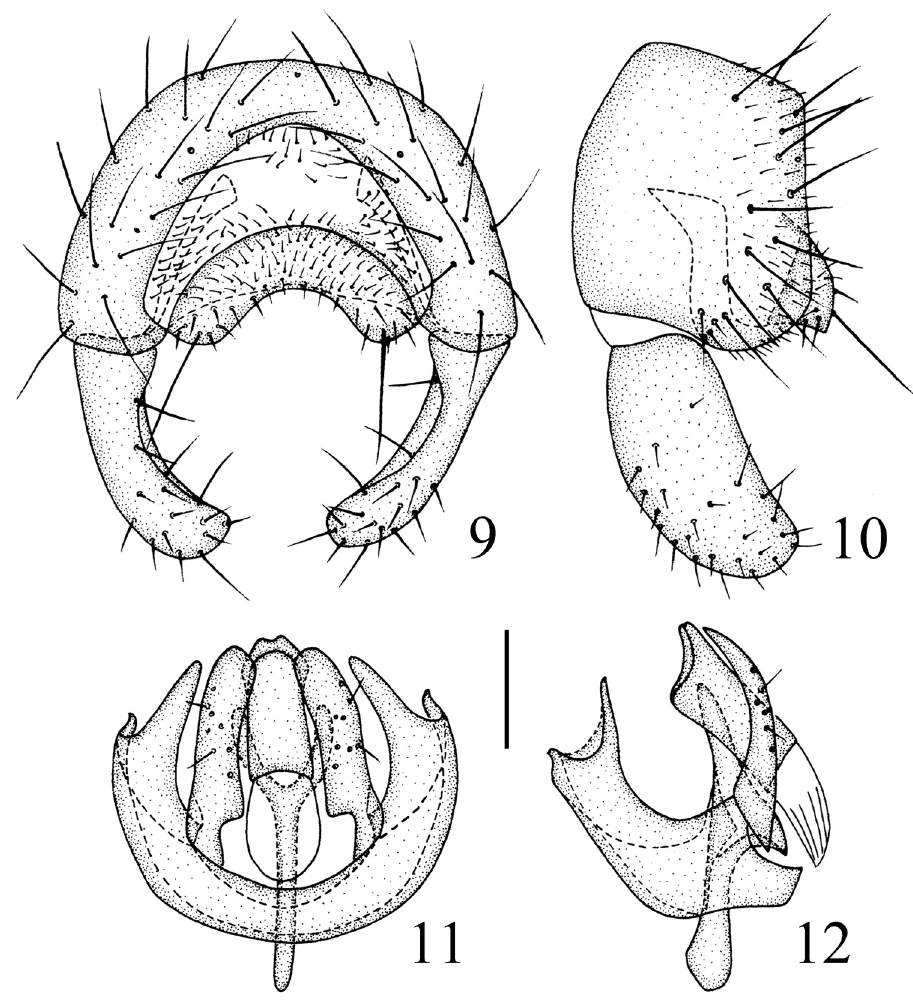
Figures 9–12. Siphunculina scalpriformis sp. n., holotype. 9 epandrium, posterior view 10 epandrium, lateral view 11 hypandrium and phallic complex, ventral view 12 hypandrium and phallic complex, lateral view. Scale bar: 0.1 basal segment brownish, with short pubescence. Proboscis black to yellowish brown with yellow setulae; palpus yellow with yellow setulae. Thorax black with gray microtomentum, evenly covered with short setulae. Scutum as long as wide. Thoracic pleuron shiny black without microtomentum. Scutellum 0.6 times as long as wide; 3 pairs of scutellar setae on small tubercles; apical scutellar seta short, 0.5 times as long as scutellum. Setae and setulae on thorax yellow; notopleurals 1+1, developed. Legs with coxae black, femora black with distal tips yellow, fore tibia yellow with weakly infuscated medially, mid and hind tibiae black with both tips yel-